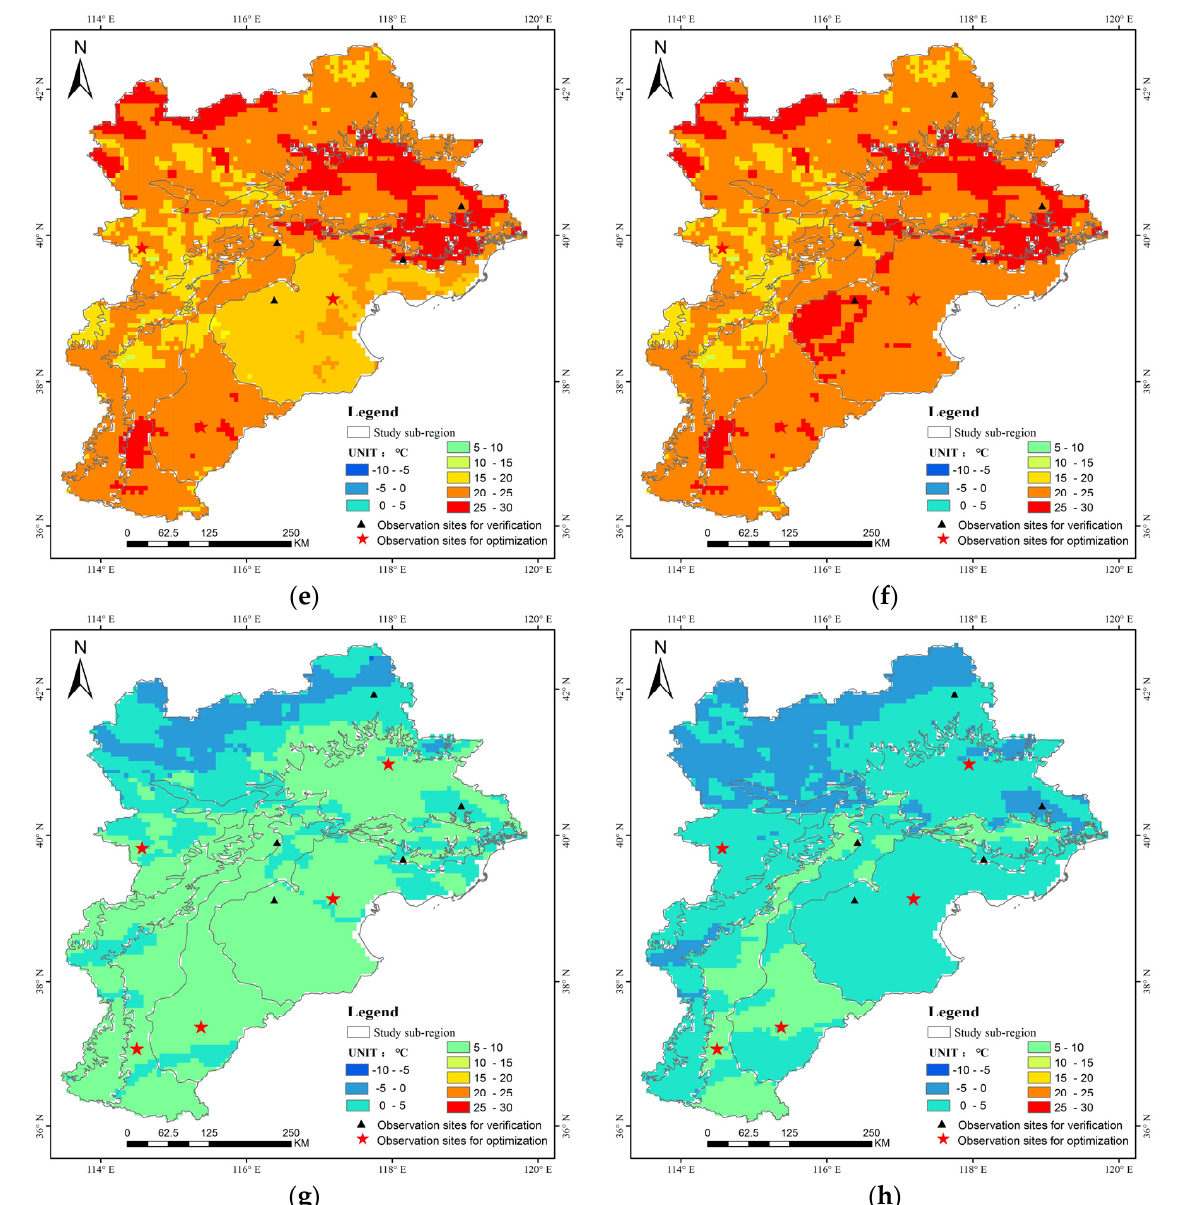
Figure 3. The spatial distribution of the land surface temperature in the Beijing–Tianjin–Hebei region in 2002 before and after reconstruction. ( a , b ) 15 February; ( c , d ) 15 May; ( e , f ) 15 August; and ( g , h ) 15 November.